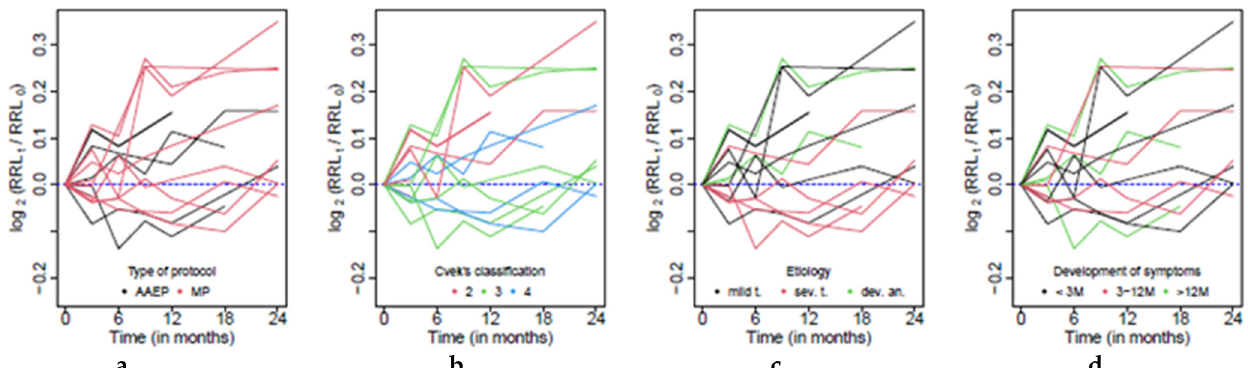
Figure 2. Graphical representation of radiographic root length (RRL) change in time in view of the ( a ) Type of protocol; ( b ) Cvek’s classification; ( c ) Etiology; ( d ) Time of development of symptoms.